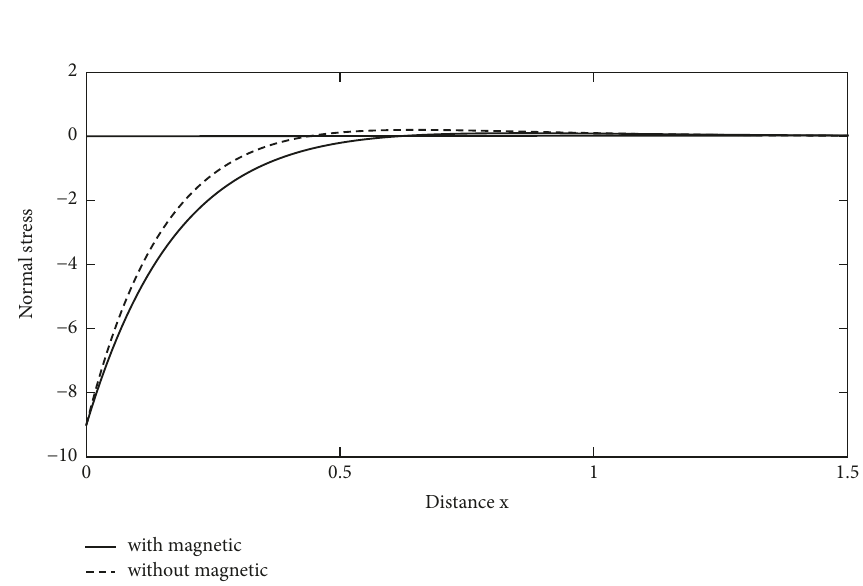
Figure 10: Effect of magnetic field on normal displacement.